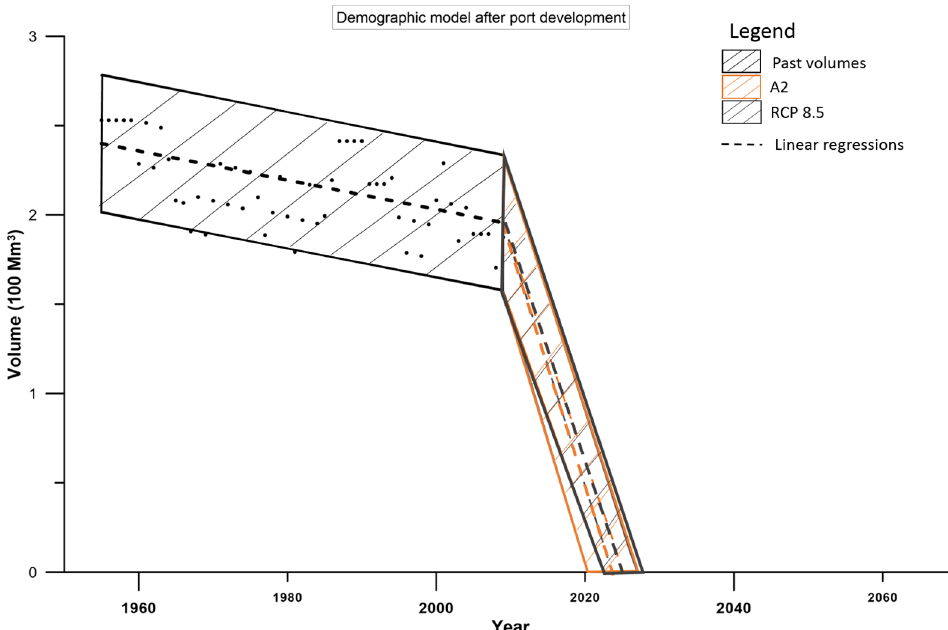
Figure 14. Graph, with the shaded areas representing the effective volume of Shela aquifer and projected volumes for A2 and RCP 8.5 climate change scenarios, as well as the uncertainties for the demographic model with the port construction completed (“LAPSSET development”).